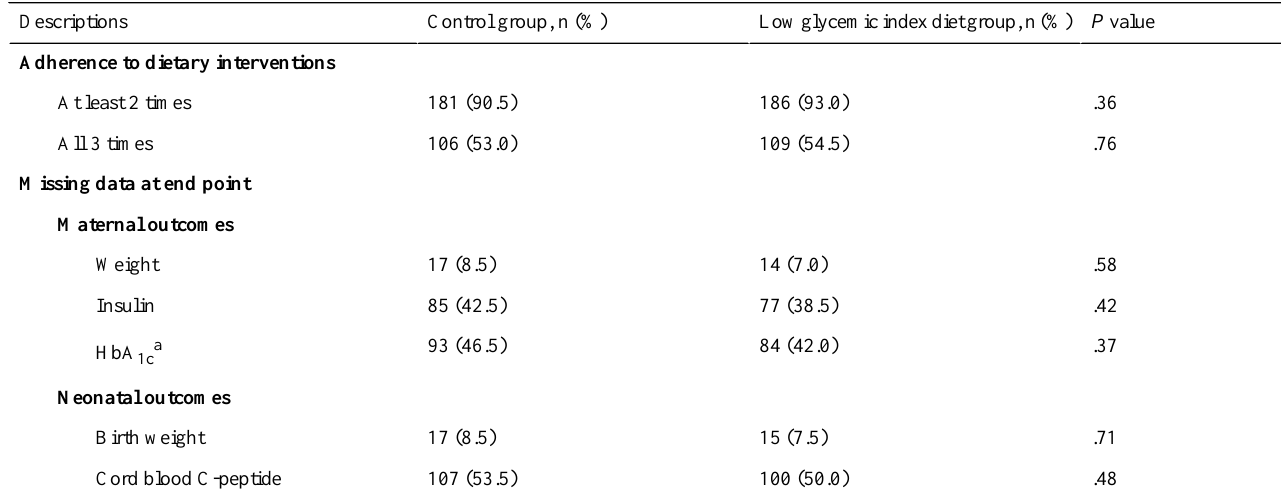
Table 4. Comparisons of adherence to dietary interventions and missing data in the low glycemic index (LGI) diet group and the control group